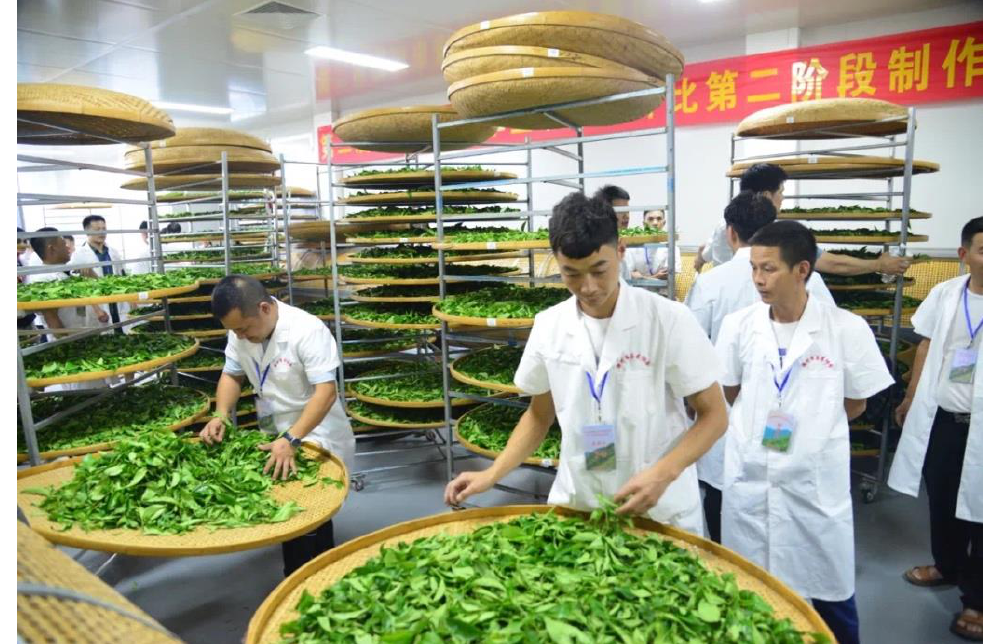
Figure 3. Tea farmers in a tea processing competition. Source: WeChat channel “Zero distance with Fenghuang （与凤凰零距离） ” (WeChat is one of the most famous social media in China)